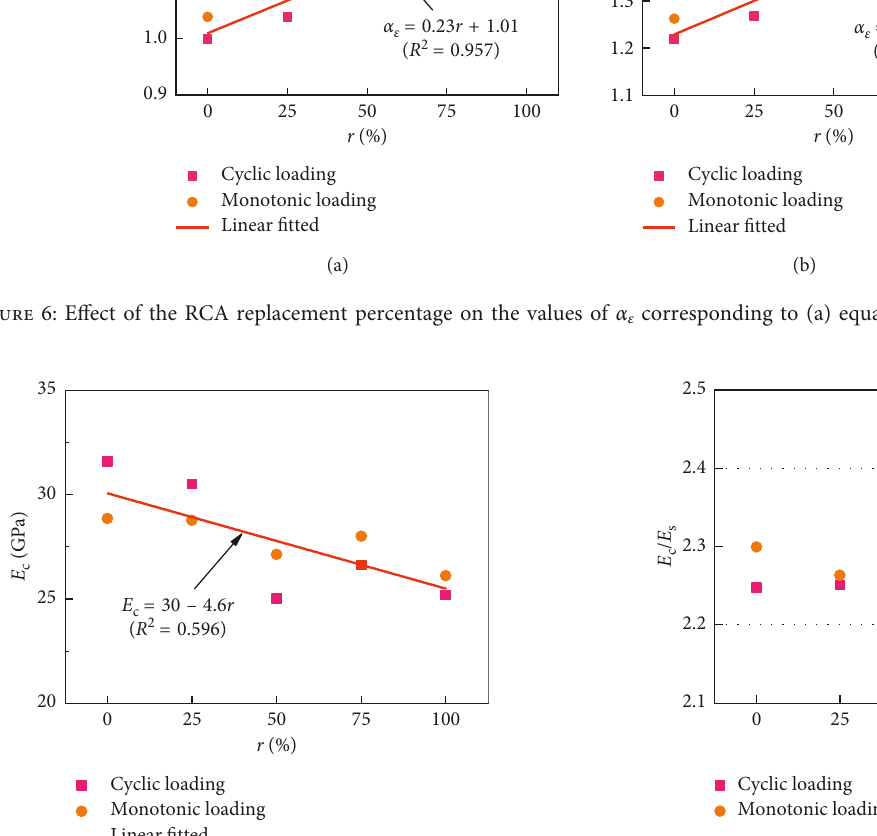
Figure 8: Relations between elastic modulus and secant modulus.